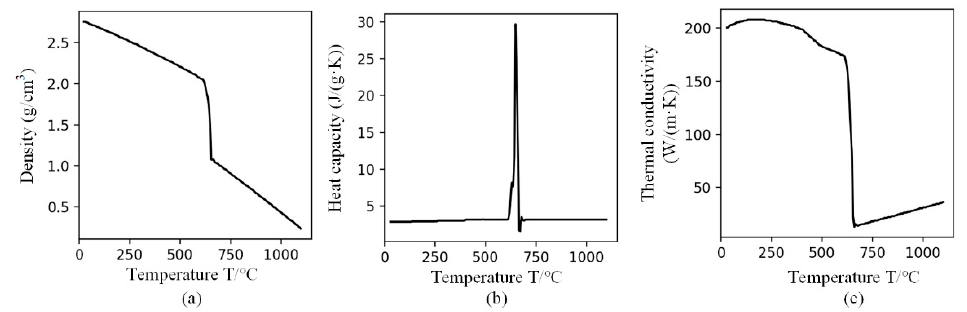
Figure 3. Thermophysical property parameters of 6005A aluminum alloy material: ( a ) the density of 6005A aluminum alloy change curve with temperature; ( b ) the heat capacity of 6005A aluminum alloy change curve with temperature; ( c ) the thermal conductivity of 6005A aluminum alloy change curve with temperature.